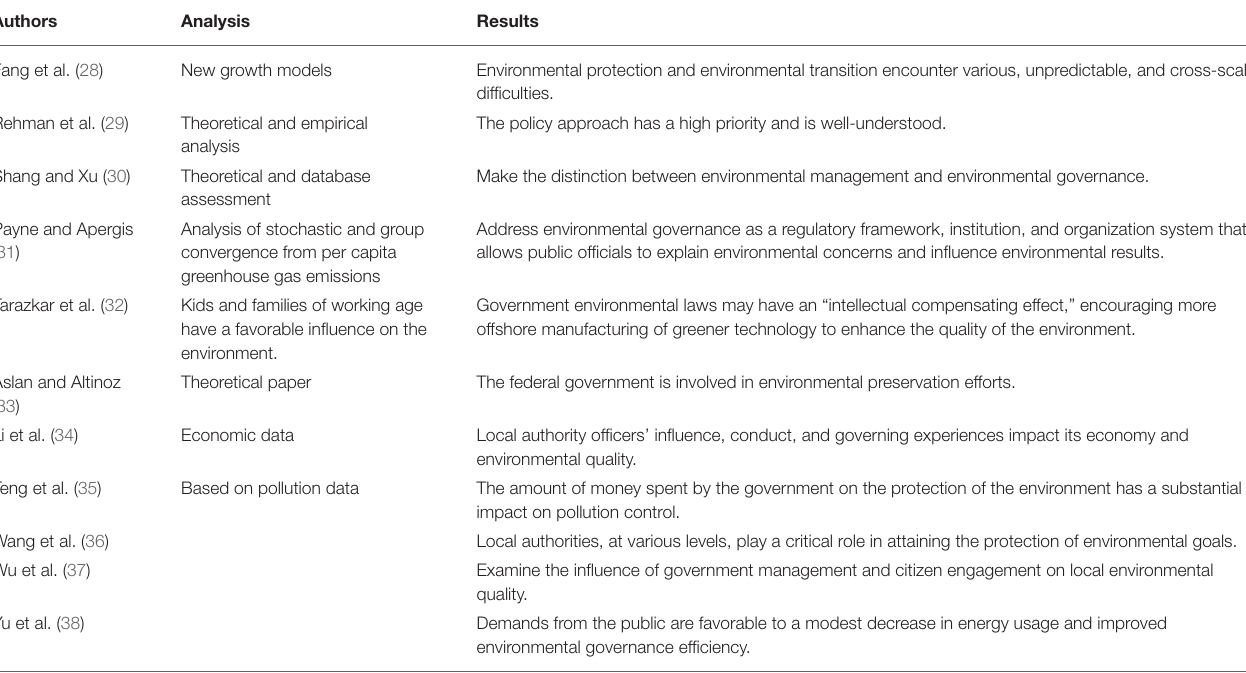
TABLE 1 | Literature summary of governance policies impacted on the environment.